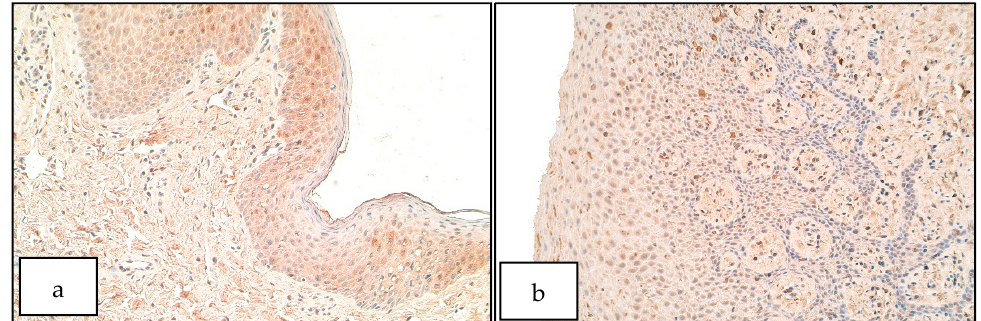
Figure 6. Immunoreactive structures for SOX3. ( a ) Moderate number of SOX3 positive structures in the patient epithelium and connective tissue. SOX3 IHM, 200×. ( b ) Few to moderate positive structures in the control group epithelium, SOX3 IHM, 200×.